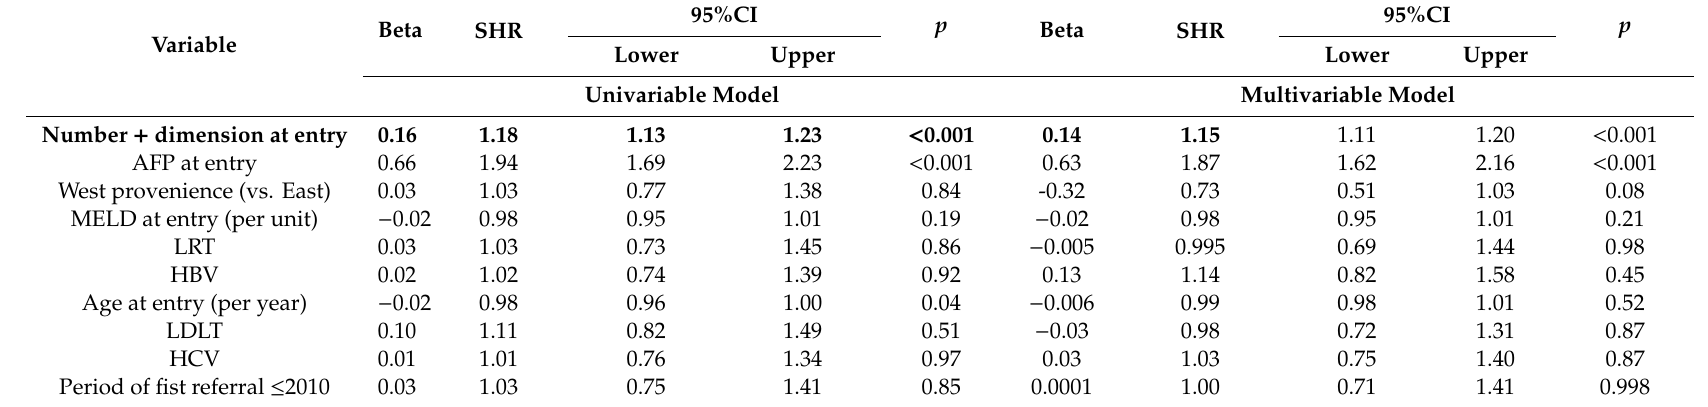
Table 2. Model for the risk of post-transplant HCC-related